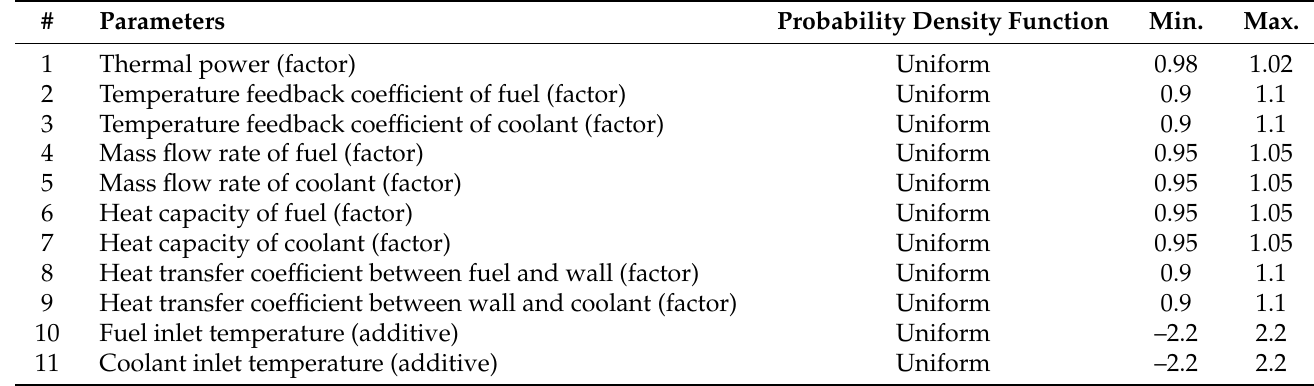
Table 4. Uncertain